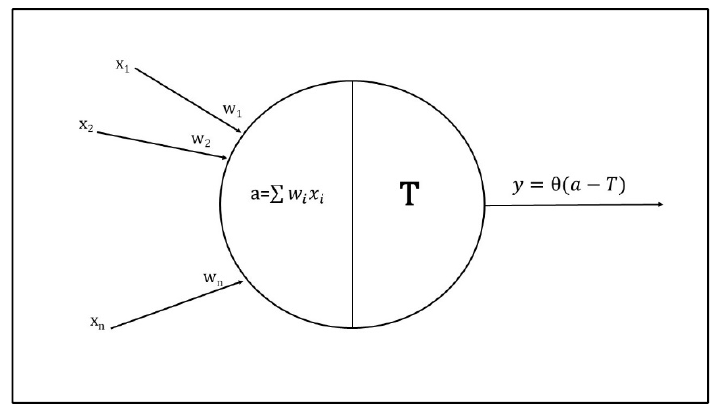
Figure 1. Example of the model of neural propagation.